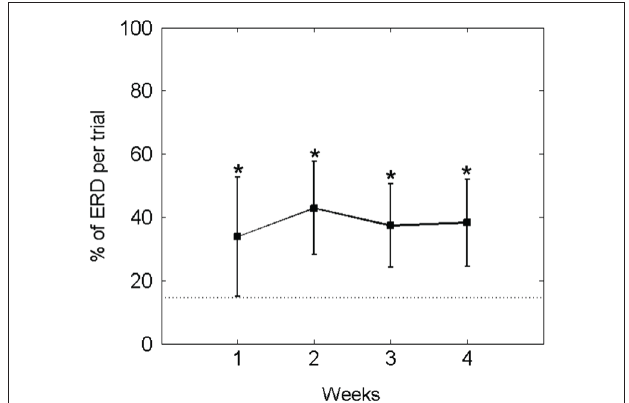
FIGURE 7 | Percentage of average ECoG-based orthosis movement (i.e., event-related desynchronisation [ERD] in the beta-band) divided by the total feedback duration phase: The mean ± standard deviation of the performance measure per week is indicated by solid lines . The mean of the baseline data is indicated as a dotted line. An asterisk ( ∗ ) marks weeks in which the mean of the performance measure differs significantly ( p < 0.05) from the mean of the baseline